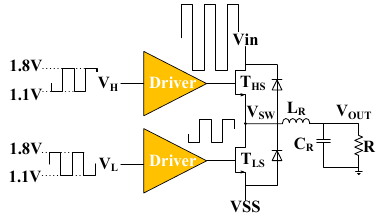
Figure 1. GaN switching DC-DC topology .